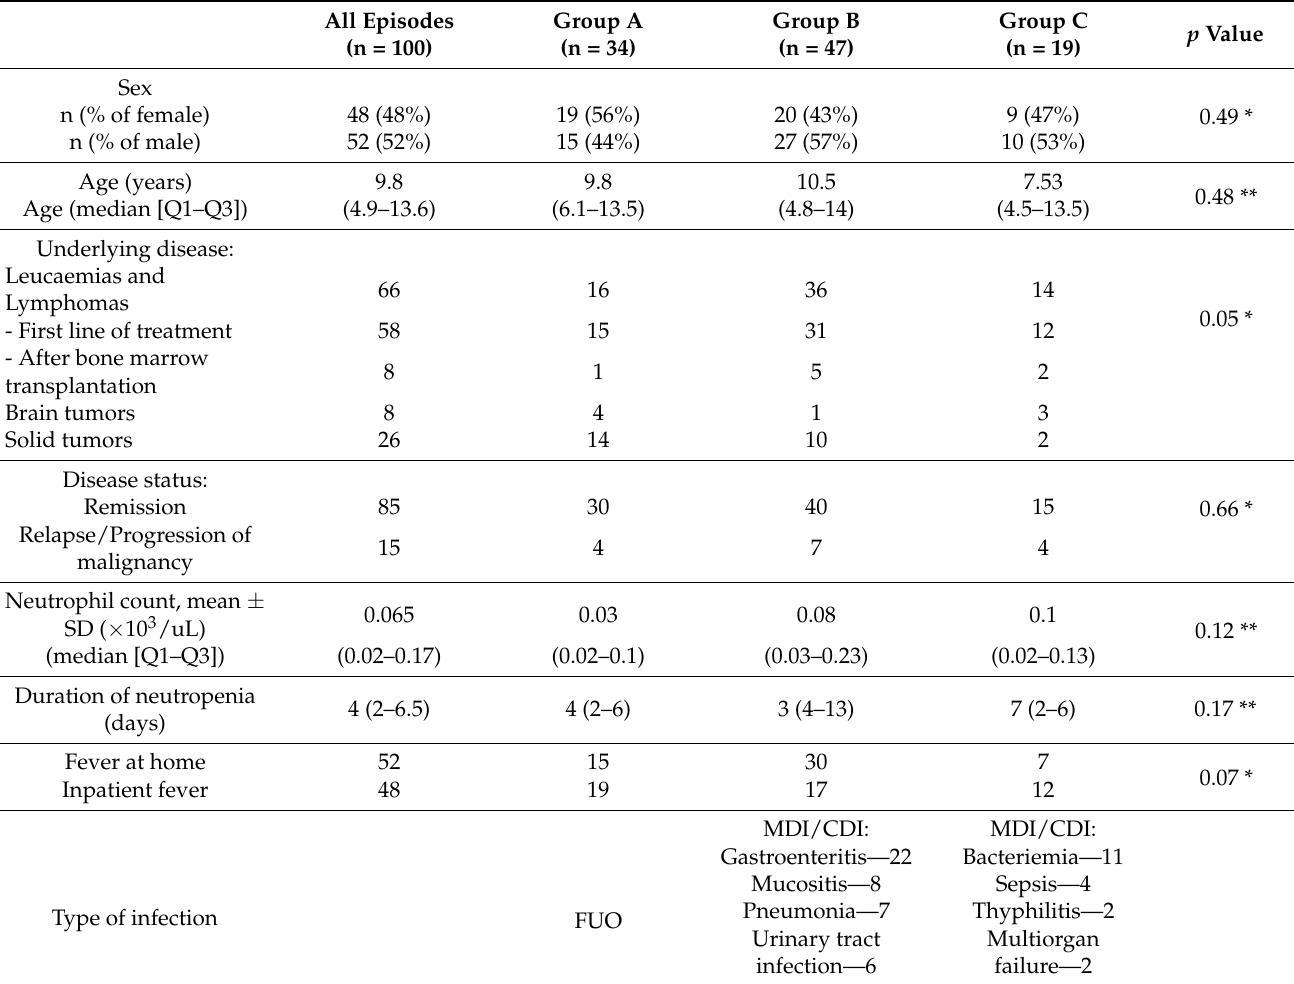
Table 1. Characteristic of the study